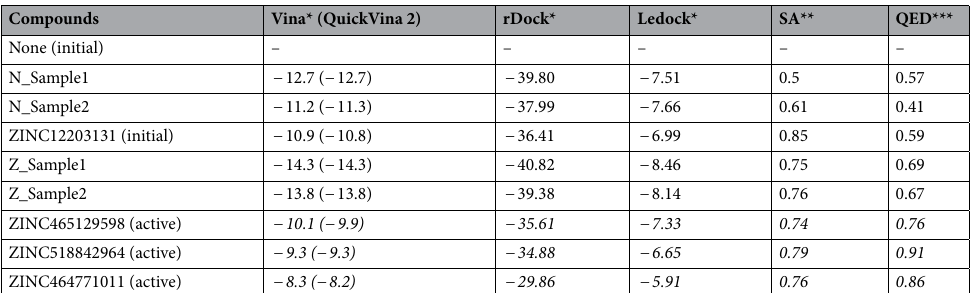
Table 2. Docking scores calculated by four popular docking programs (AutoDock Vina, QuickVina 2, rDock, Ledock), as well as SA and QED scores for the D4DR agonists. Data in italics indicates active inhibitors from Lyu et al. 10 . *For docking scores, the lower, the better. The unit of Vina, QuickVina 2, and Ledock score is kcal/ mol. **Synthetic accessibility. ***Quantitative estimate of